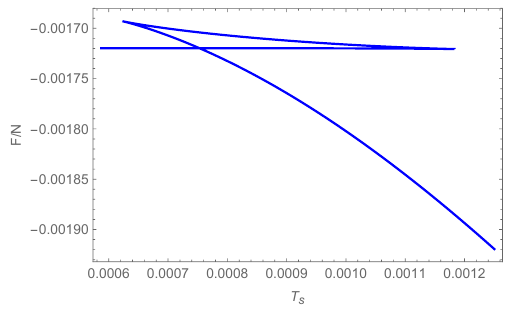
as a function of the temperature T s of the system. In N